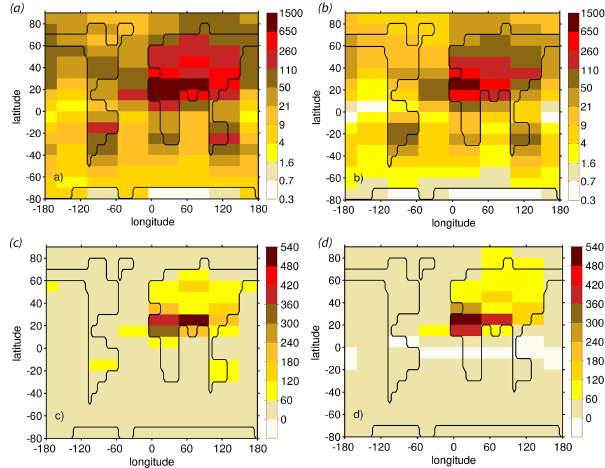
Figure 3. Geographic distributions of atmospheric dust load (mgm − 2 ) from solution L1 for 21ka (a) and 0ka (b) with a log- arithmic scale. Difference distributions of dust load shown with a linear scale for 21ka relative to 0ka from solution L1 (c) and from solution L1 relative to solution L2 for 21ka (d)